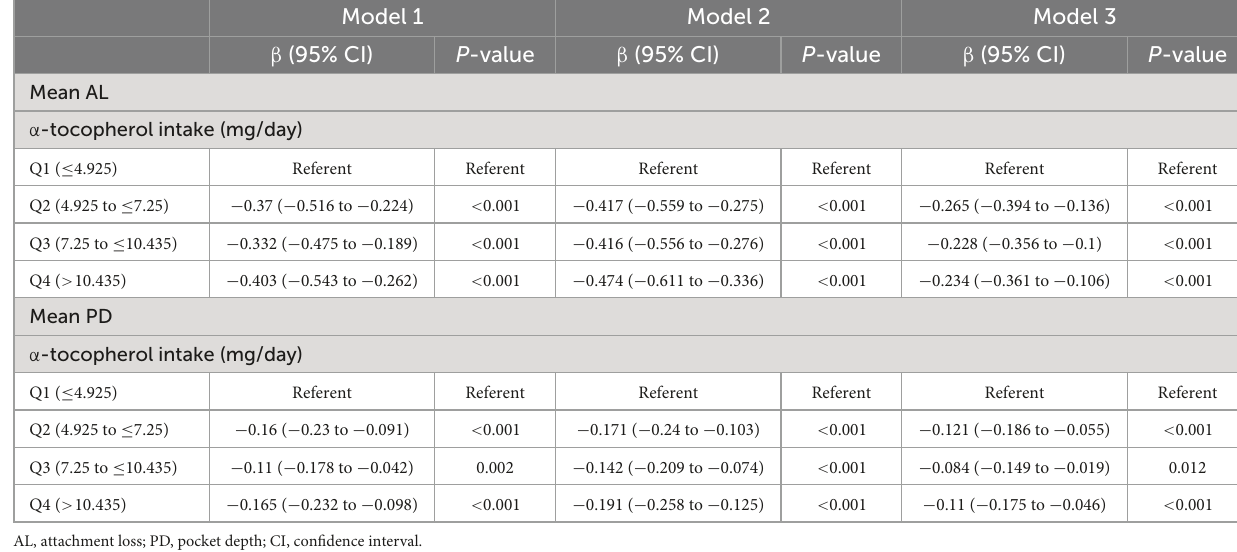
TABLE 6 β (p) of mean PD and mean AL according to the quartile of α -tocopherol intake.